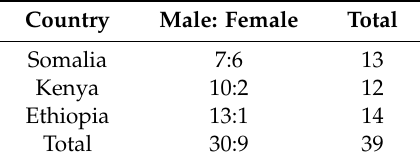
Table 1. Number of respondents interviewed from the three participating countries. Country Male: